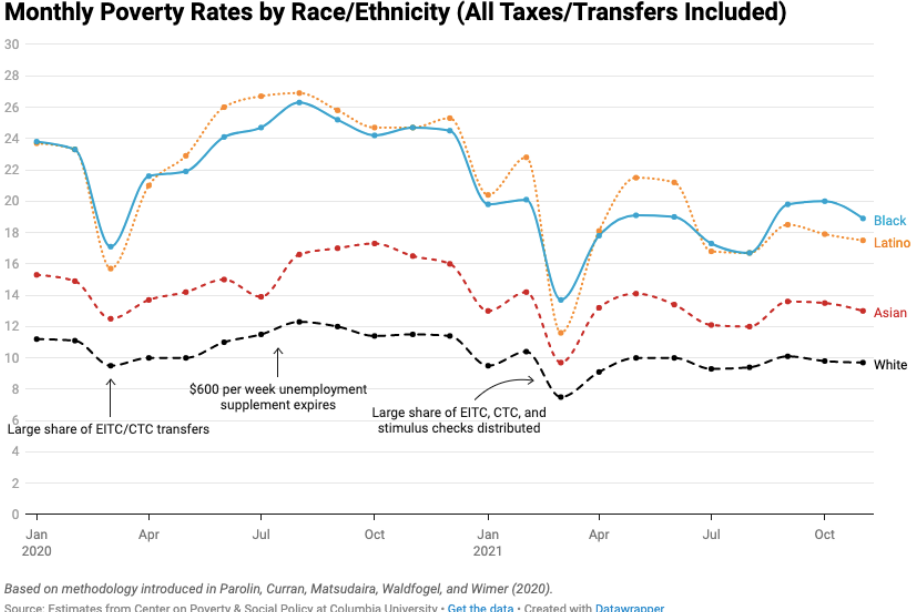
Figure 6. Monthly estimates of the Supplemental Poverty Measure from the Center on Poverty and Social Policy at Columbia University by race/ethnicity, January 2020–July 2021 [31]. Black and Latino poverty levels were more severely impacted by the COVID-19 pandemic than White and Asian populations. Permission for usage of this chart was obtained from Columbia University’s Center on Poverty and Social Policy.